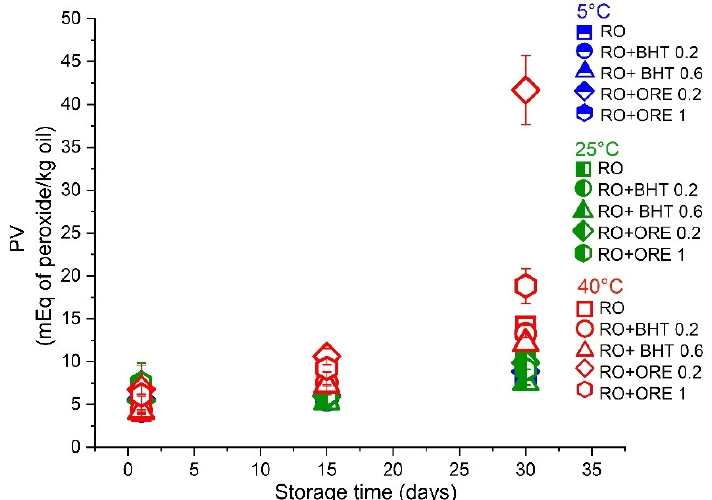
Figure 3. Peroxide values of oil samples (pure raspberry oil–RO) and RO with added antioxidants (butylated hydroxytoluene—BHT, 0.2 or 0.6 wt%, and oregano essential oil—ORE, 0.2 or 1 wt%) at 5, 25, and 40 °C during one month of storage. The results are expressed as milliequivalents of peroxide/kg oil, determined according to the IDF method.